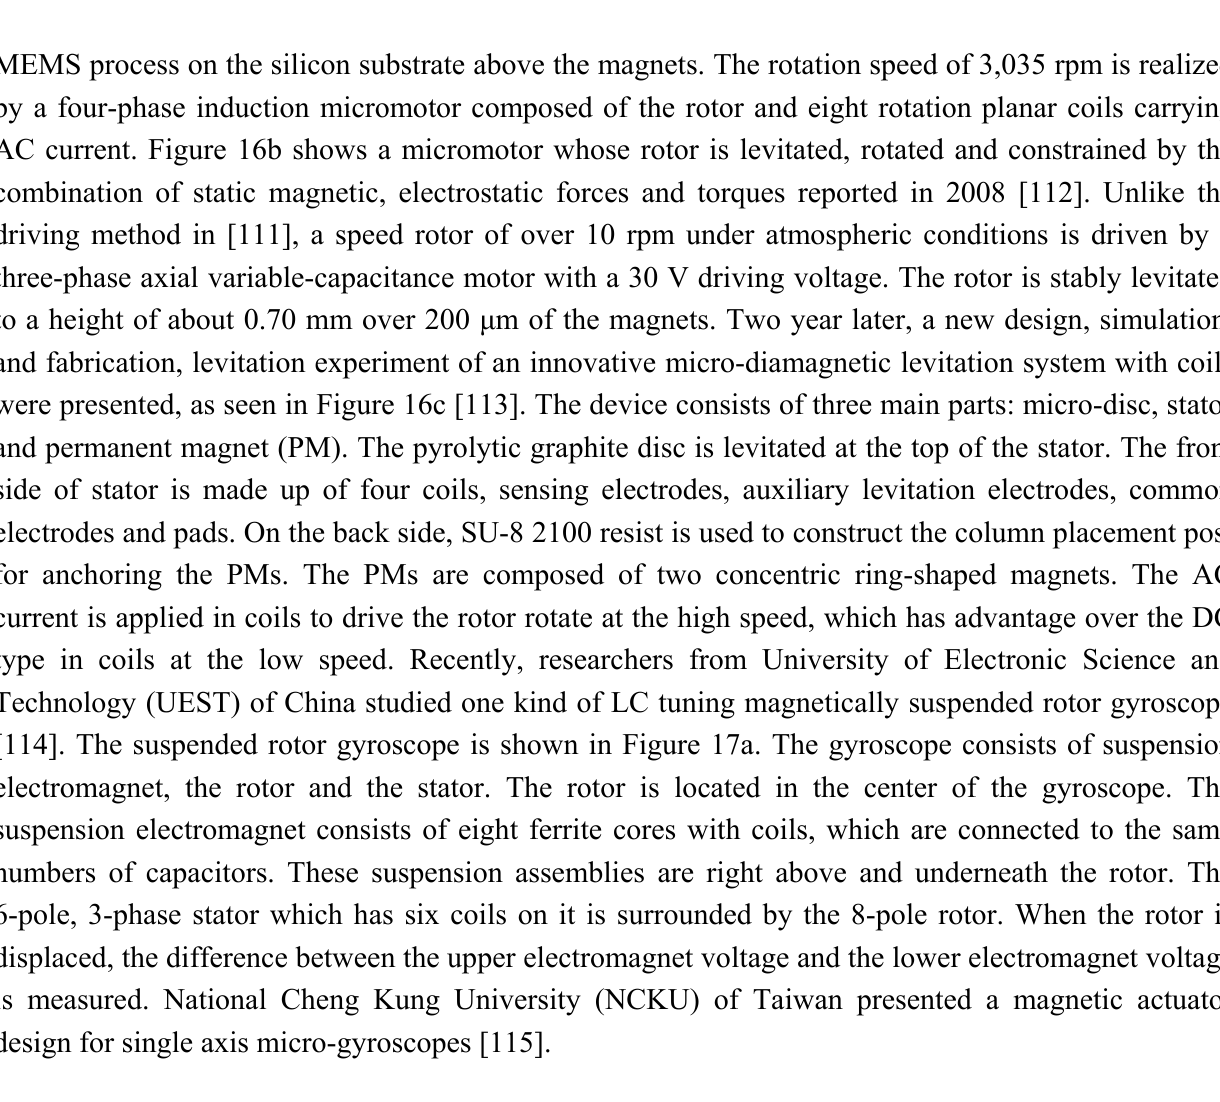
Figure 16. MSGs of SJTU. ( a ) The gyroscope designed in 2006. ( b ) The gyroscope designed in 2008. ( c ) The gyroscope designed in